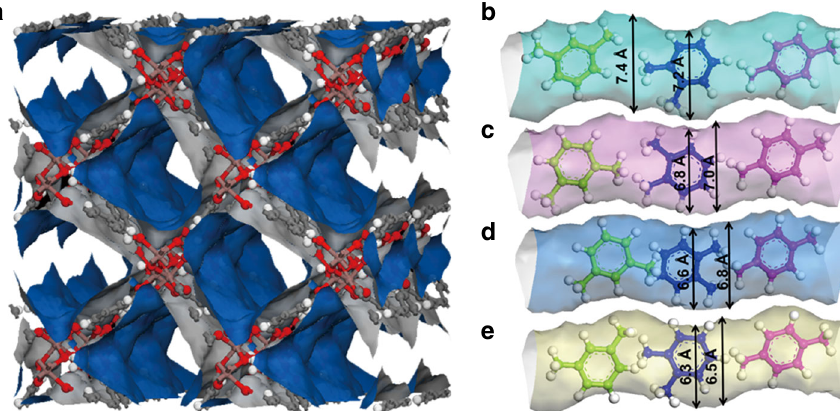
Fig. 1 Views of crystal structures of MFM-300. a Projected view along the c axis and views of the one-dimensional channels in MFM-300, (metal, purple; carbon, grey; oxygen, red; hydrogen, white), b views of MFM-300(In), c MFM-300(V), d MFM-300(Fe), e MFM-300(Al). The pore dimensions were obtained using Material Studio software based on the CIFs of MFM-300 determined from X-ray diffraction experiments. The molecular structures for three xylene isomers are also included for comparison with the pore dimensions. The pore sizes are: MFM-300(Al) (6.5 – 6.3 Å), MFM-300(Fe) (6.8 – 6.6 Å), MFM-300(V) (7.0 – 6.8 Å), MFM-300(In) (7.4 – 7.2 Å). MFM-300(Al) has a slightly narrower pore than the dimensions of o - and m -xylene isomers, as